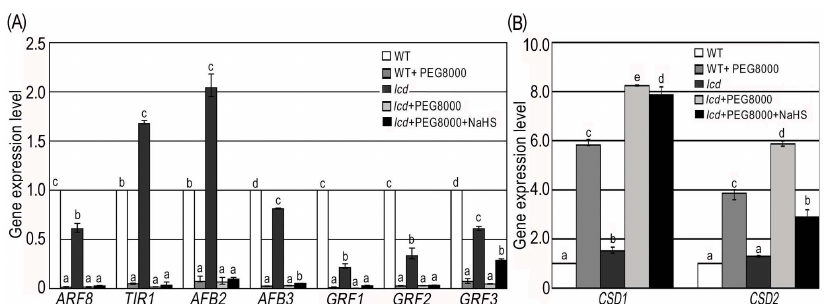
Figure 5. Target gene expressions in WT and lcd plants treated with PEG8000 and NaHS. ( A ) ARF8 , TIR1 , AFB2 , AFB3 , GRF1 , GRF2 and GRF3 expression in WT and lcd treated with 50 m mol L 2 1 NaHS and 0.2 g ml 2 1 PEG8000; ( B ) CSD1 and CSD2 expression in WT and lcd treated with 50 m mol L 2 1 NaHS and 0.2 g ml 2 1 PEG8000. The same treatments were applied as in Figure 4. ACTIN was used as an internal control in qRT-PCR. Results are shown as mean 6 SE (n=3 independent experiments). Letter numbers indicate significant differences between treatments within one gene ( P , 0.05 ).